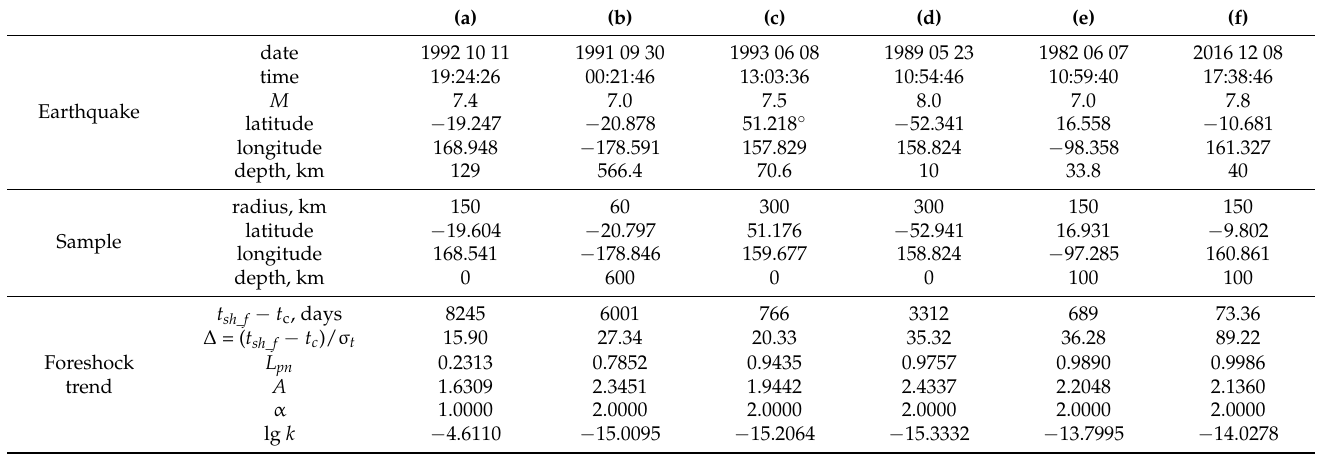
Table A1. Data on the main shock, sample and some characteristics of the foreshock trend for the examples of retrospective prediction extrapolations given in Figure